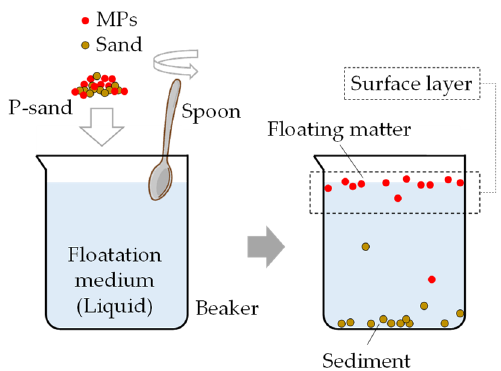
Figure 2. Input of P-sand and floating of MPs with a density that is lower than the liquid.